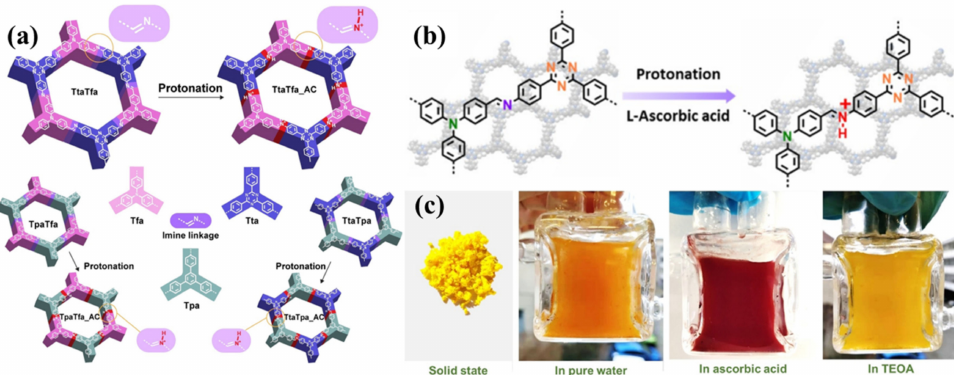
Figure 2. ( a ) Synthesis of the COFs studied in this work. AC = ascorbic acid modification. EPR conduction band electron spectra of ( b ) the protonation of TtaTfa with L-ascorbic acid. ( c ) Color of TtaTfa powder and dispersion at different reaction conditions. Reproduced with permission from Ref. [41]. Copyright: Angewandte Chemie International Edition,